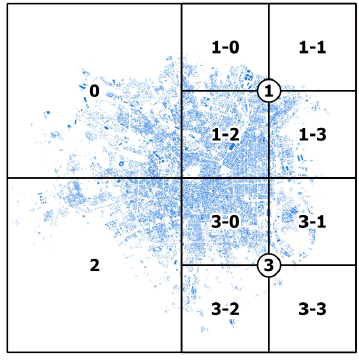
Figure 3. Regular square grids and relative cell numbers used to create heterogeneous regions for local analysis